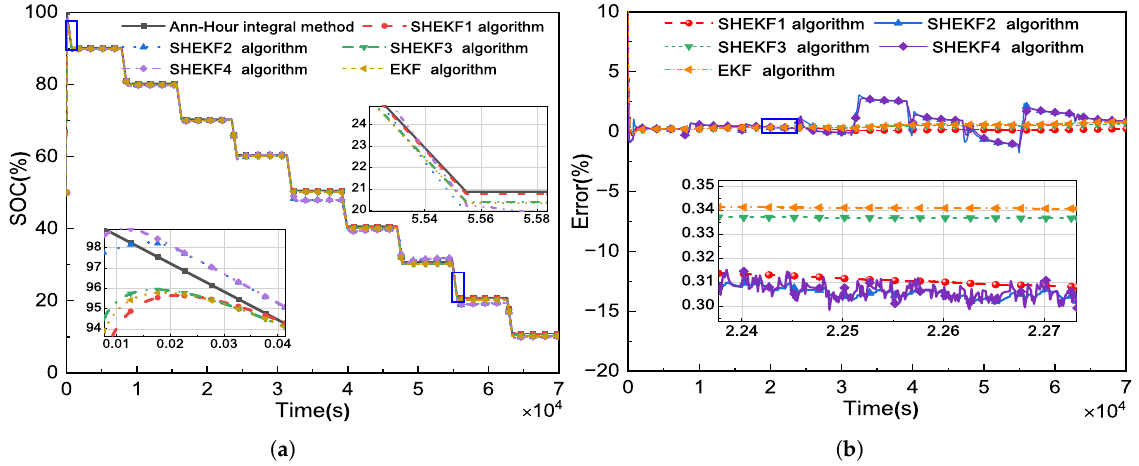
Figure 9. Algorithms comparison and its error curve with incorrect SOC initial value: ( a ) SOC with the initial value of SOC is 0.5, ( b ) Error with the initial value of SOC is 0.5